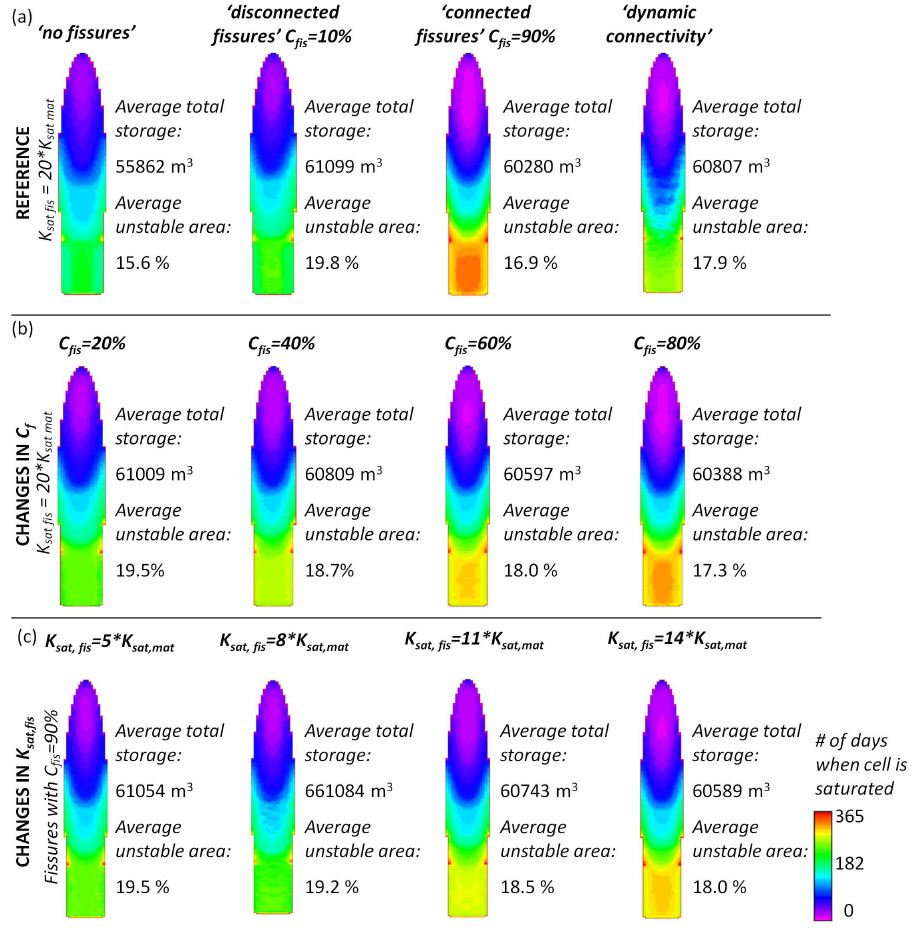
Fig. 11. Sensitivity analysis of the model for changes in conceptualisation of fissure connectivity: (a) is the reference panel – the “no fissures”, “disconnected fissures”, “connected fissures” and “dynamic connectivity” scenarios; (b) changing fissure connectivity ( C fis ) for the simulation with fissures included ( C fis is constant over the simulation period); (c) changing saturated hydraulic conductivity for the “connected fissures”